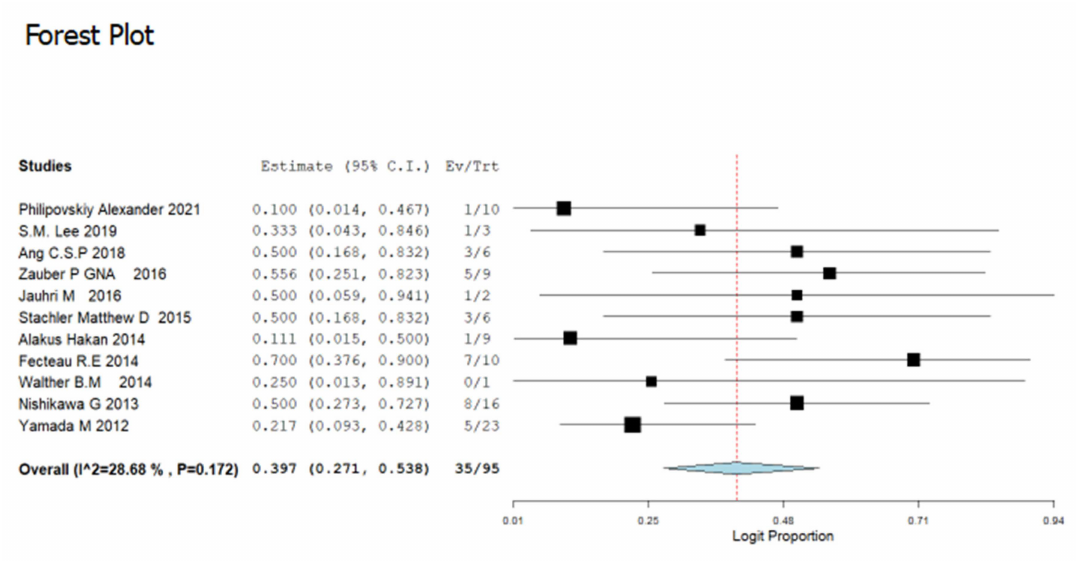
Figure 4. Forest plot for GNAS codon R201H in CRC patients [1,6,14,22,24,33,36–39,42].